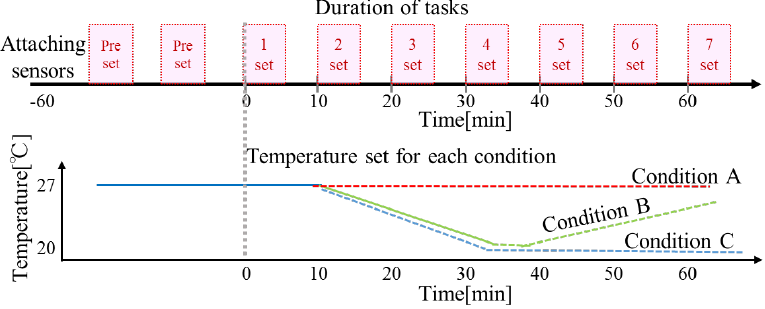
Figure 2. Experimental conditions and environmental procedure.